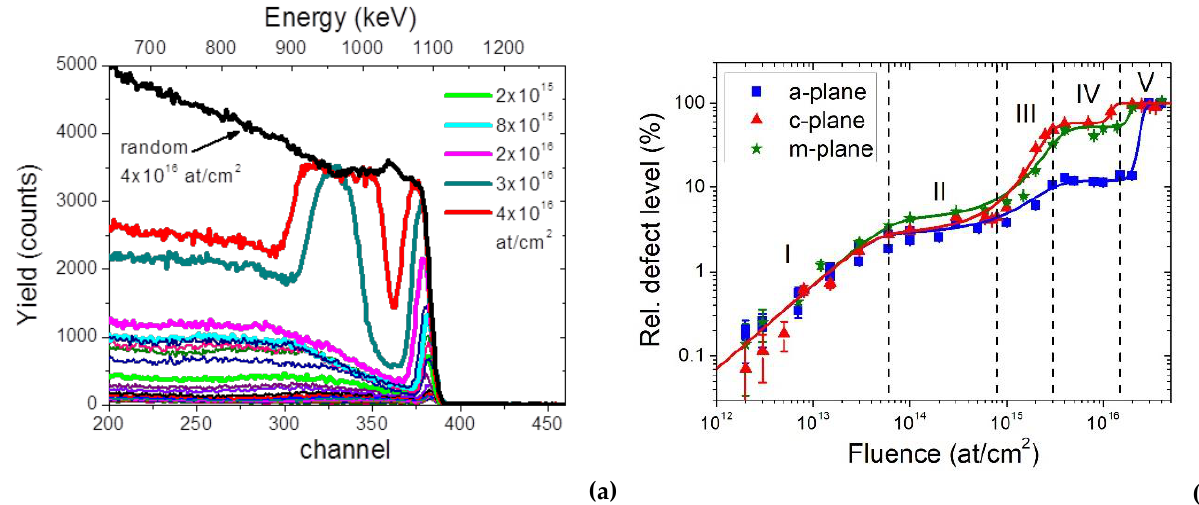
Figure 2. ( a ) Rutherford backscattering spectrometry/channelling (RBS/C) aligned spectra for a- plane GaN samples implanted using different fluences (only some of which are indicated in the legend for clarity) of 300 keV Ar at 15 K. The random spectrum for the sample implanted to the highest fluence is also shown. ( b ) Relative defect level as a function of the implantation fluence for a-, c- and m-plane samples. The solid lines are fits using the Hecking model. Adapted with permission from Ref. [44].